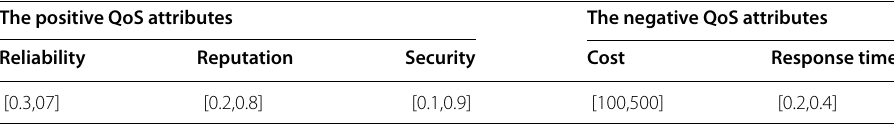
Table 1 QoS attributes considered for the simulation The positive QoS attributes The negative QoS attributes Reliability